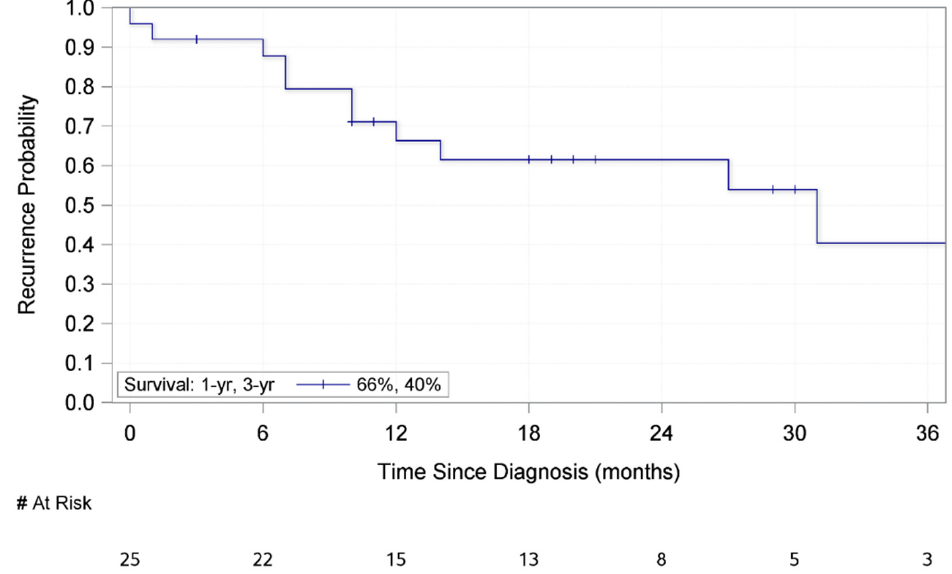
Figure 1. Kaplan–Meier Curve for Recurrence Free Survival of 25 patients who Underwent Surgical Resection of a Subungual Melanoma.